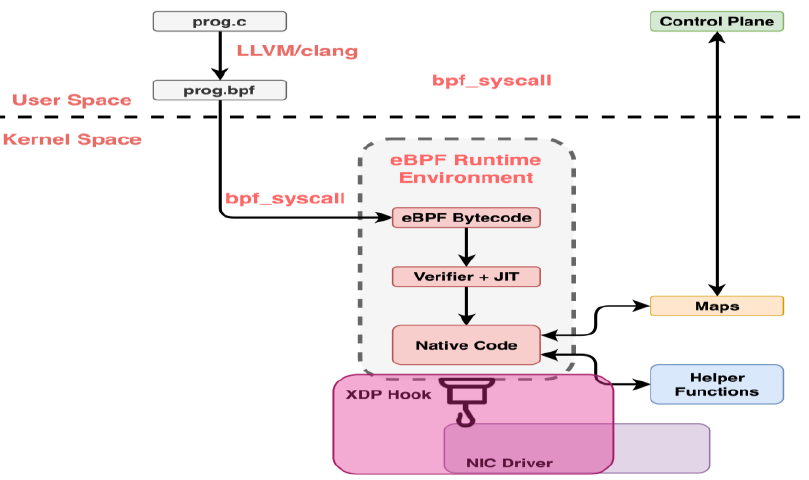
Figure 2. XDP workflow and architecture.